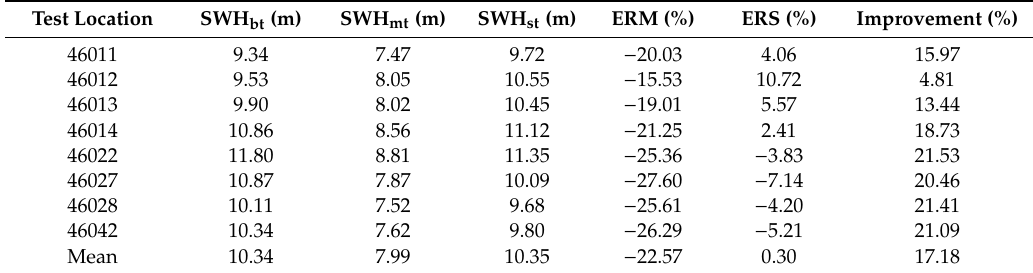
Table 1. Pacific Coast: results for T R = 50 years.